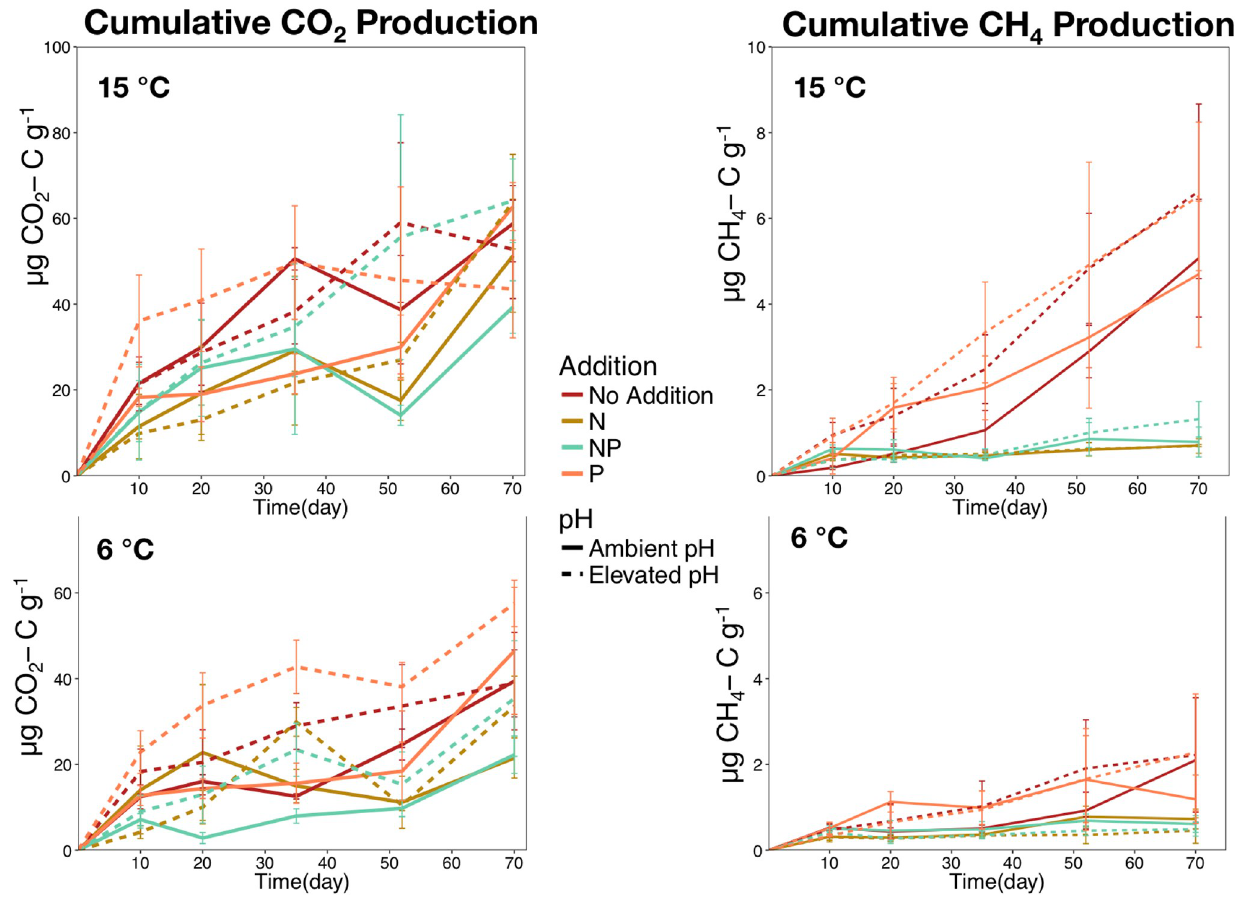
Fig 1. Cumulative production of CO 2 (left) and CH 4 (right) in peat microcosms incubated at at 6 (bottom) and 15 ˚ C (top) . Nutrient addition treatments are coded by color and the elevated pH treatment is represented by dashed